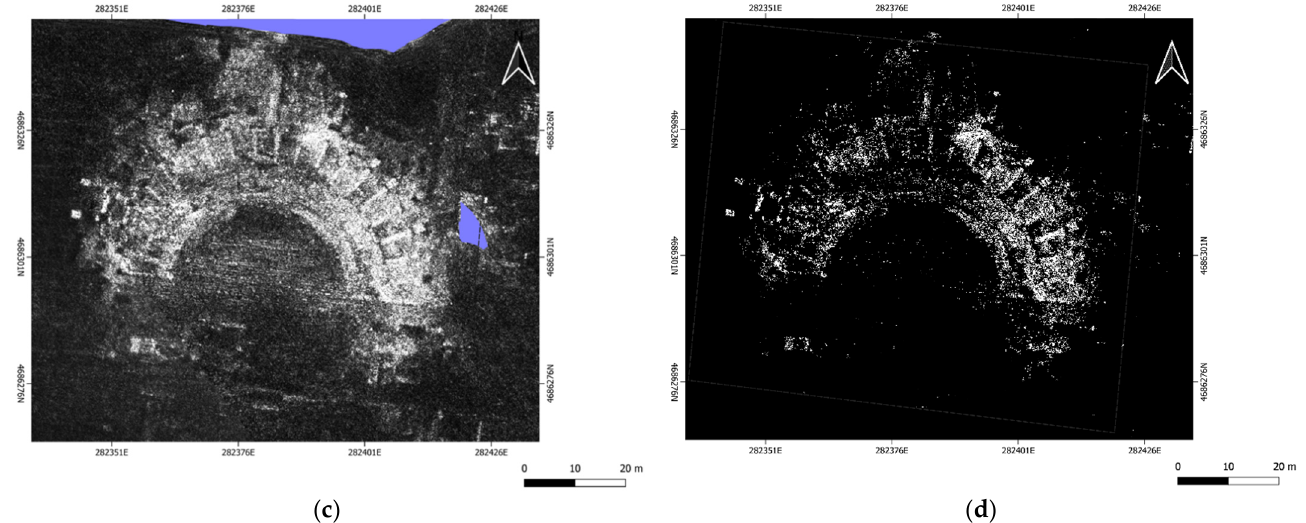
Figure 1. Comparison between time-slices (T) and related “signal peak slices” (A) from the Falerii Novi dataset: ( a ) Field 4, time-slice 07–08 ns (estimated depth 0.3097–0.3540 m) [28]; ( b ) “signal peak slice” obtained from the processing of a on the base of pixel value 255, to which is assigned an average depth value of 0.3318 m (image by M. Serpetti); ( c ) Field 4, time-slice 17–18 ns (estimated depth 0.7522–0.7965 m) [28]; ( d ) “signal peak slice” obtained from the processing of c on the base of pixel value 255, to which is assigned an average depth value of 0.7743 m (image by M. Serpetti).